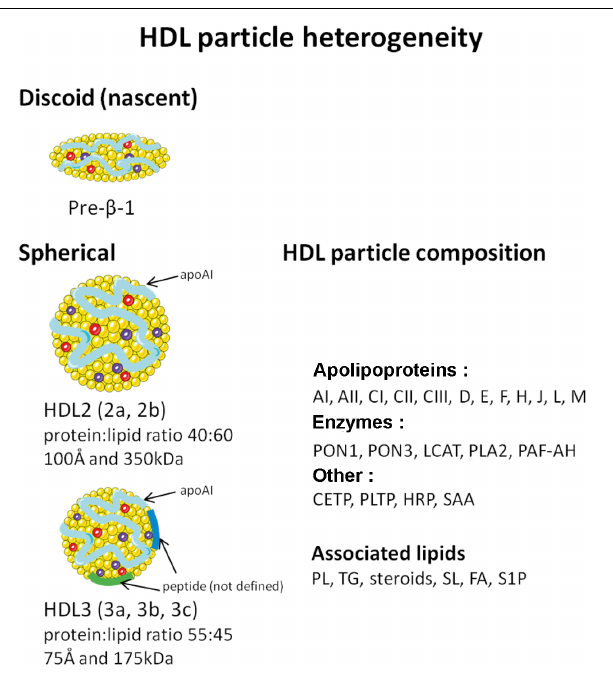
FIGURE 1 | Schematic representation of HDL heterogeneity. PON, paraoxonase; LCAT, lecithin-cholesterol acyltransferase; PLA2, phospholipase A2; PAF-AH, platelet activating factor acetylhydrolase; CETP, cholesterol ester transfer protein; PLTP, phospholipid transfer protein; HRP, haptoglobin related protein; SAA, serum amyloid AI and AII; PLs, phospholipids; TG, triglyceride; SLs, sphingolipids; FA, fatty acid; S1P,